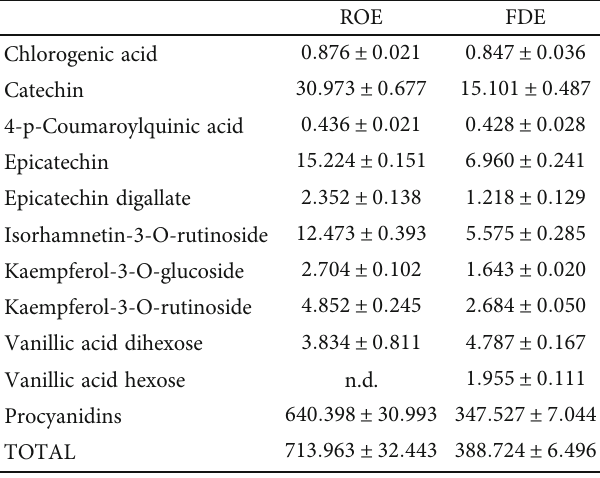
Table 3: Content (mg/kg of almond) of the main phenolic compounds in resin-obtained extracts (ROE) and freeze-dried extracts (FDE).